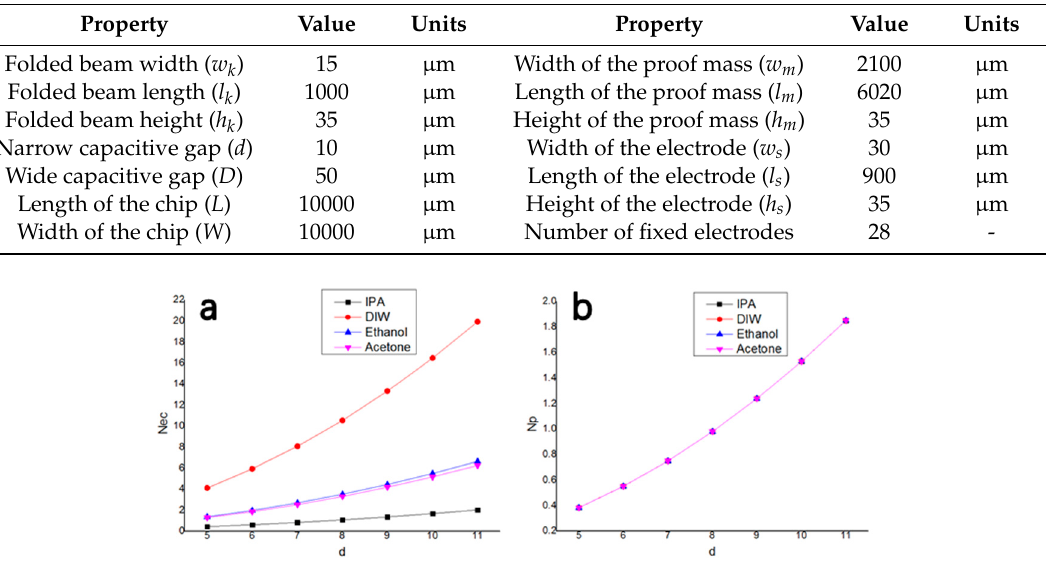
N N and P with a small spacing d : N for four